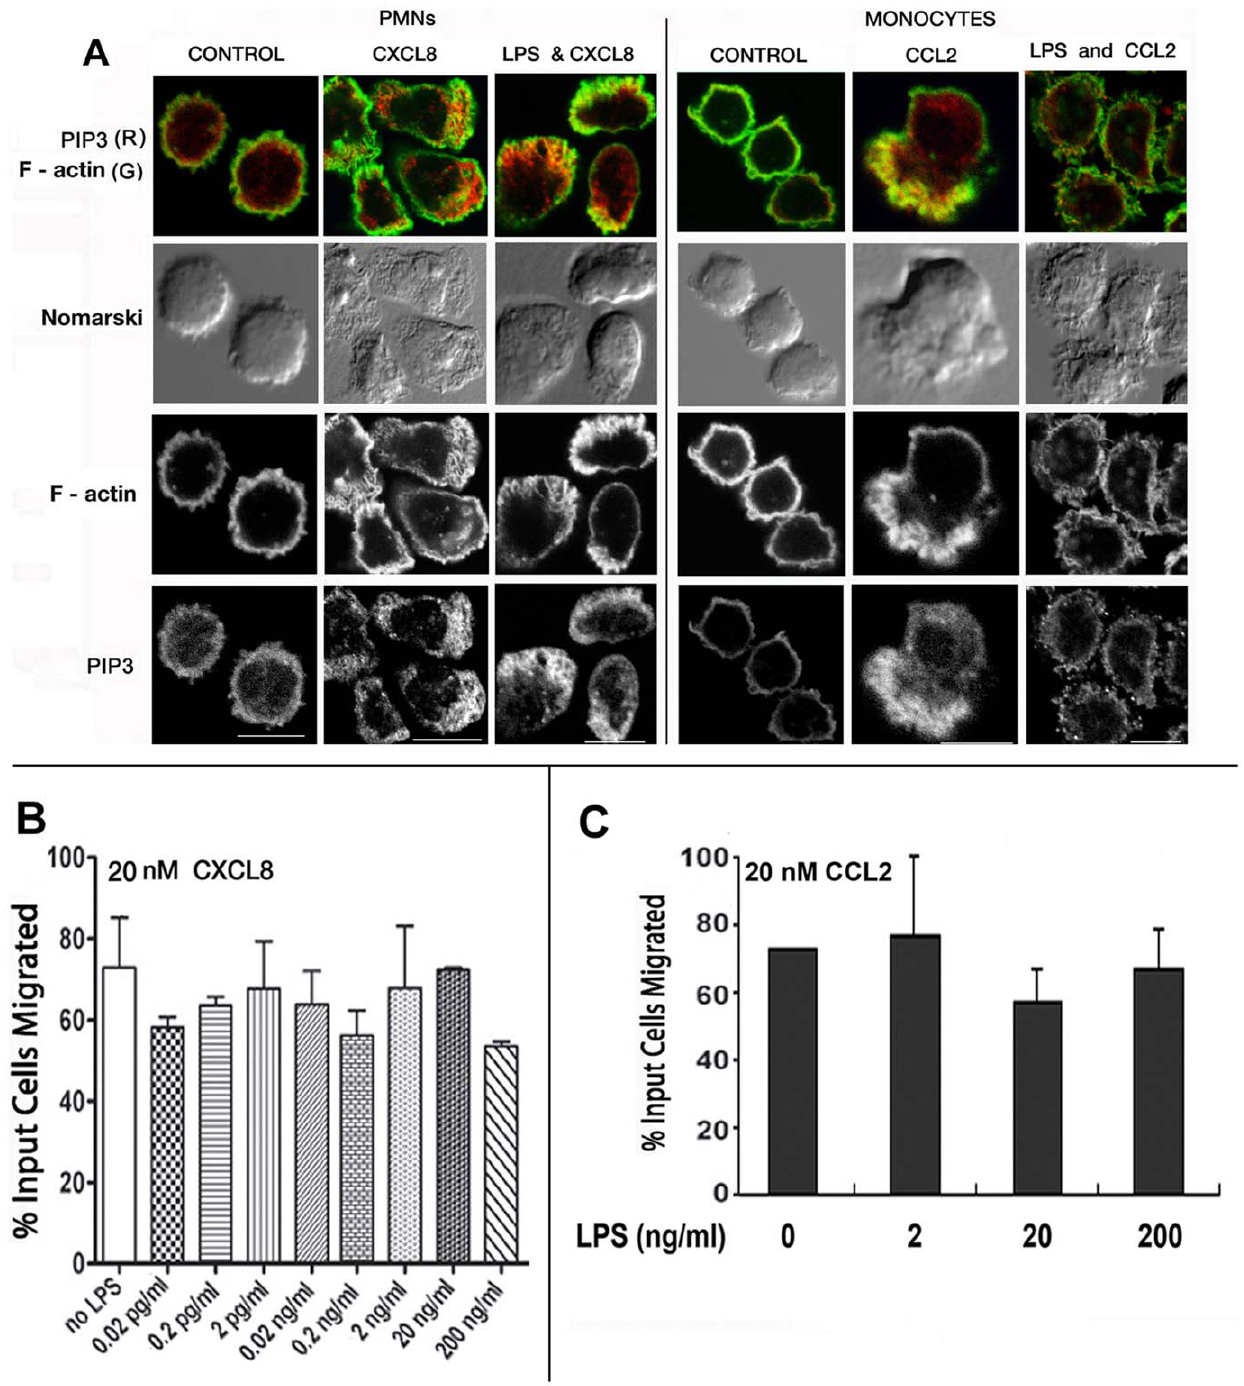
Figure 2. Differential effects of LPS on neutrophil and monocyte chemotaxis. A ) LPS pre-treatment affects the polarization of CCL2 treated monocytes but not CXCL8 treated neutrophils. Human monocytes and neutrophils were plated on cover slips and treated with or without LPS (2 ng/ ml) for 10 min at 37 u C. After washing, cells were treated with CXCL8 (PMNs) or CCL2 (MONOCYTES) at 20 nM at 37 u C for 2 min. Cells were then fixed, permeabilized and stained with Alexa568- phalloidin and FITC mAb against PIP 3 and imaged by fluorescence and DIC microscopy. B ) LPS did not significantly inhibit neutrophil chemotaxis. Human neutrophils (1 6 10 6 cells in triplicate) were treated with various concentrations of LPS in 100 m l RPMI with 5% FBS for 10 min at 37 u C. After washing, cells were suspended in 100 m l RPMI with 1% FBS and added to the upper chambers of 5.0 m m Trans-well (Corning Inc.), with or without 20 nm CXCL8 or fMLF (not shown) in the bottom well, and incubated for 2 h at 37 u C. Migrated cells were collected and counted, as described under Methods . Fraction (%) of migrated input cells are presented in the histograms (with error bars), n=3. C ) LPS treatment at 20 ng/ml induced little or no inhibition of of U937 myelmonocytic cell chemotaxis towards 20 nM CCL2, n=3.